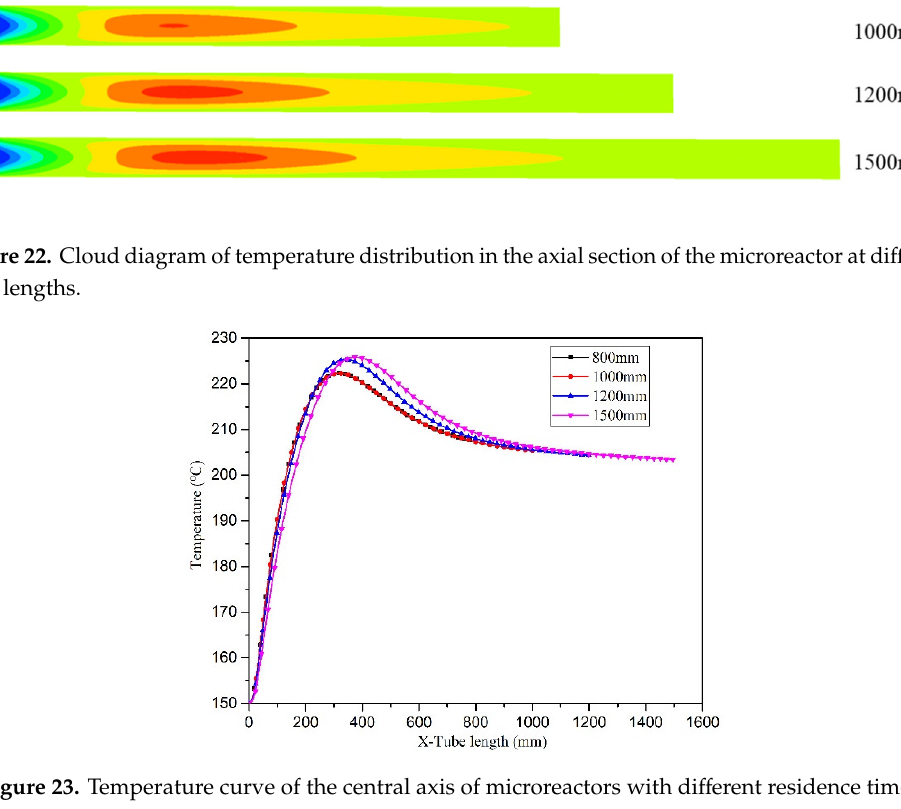
Figure 24. Polymer conversion of styrene in a microreactor at different residence times.